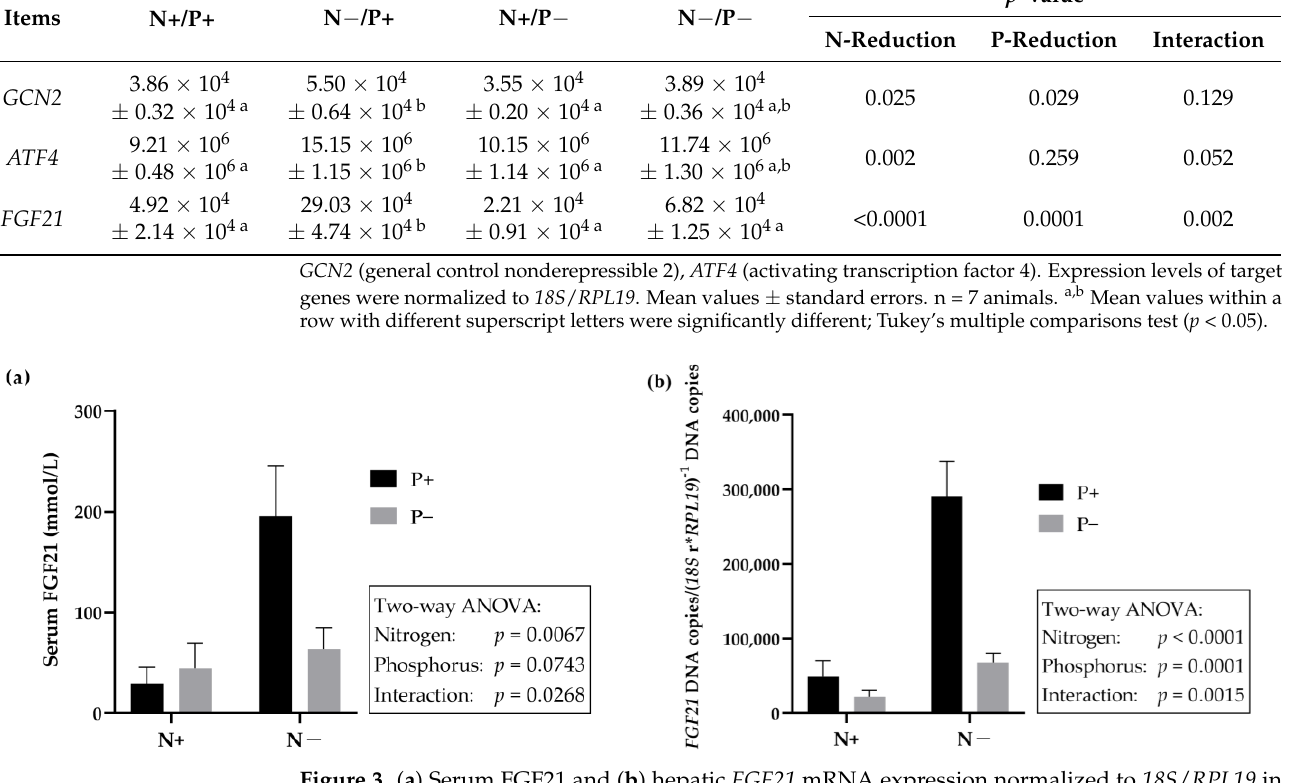
Figure 3. ( a ) Serum FGF21 and ( b ) hepatic FGF21 mRNA expression normalized to 18S / RPL19 in young goats fed an N- and/or P-reduced diet. Two-way ANOVA analysis; p < 0.05.